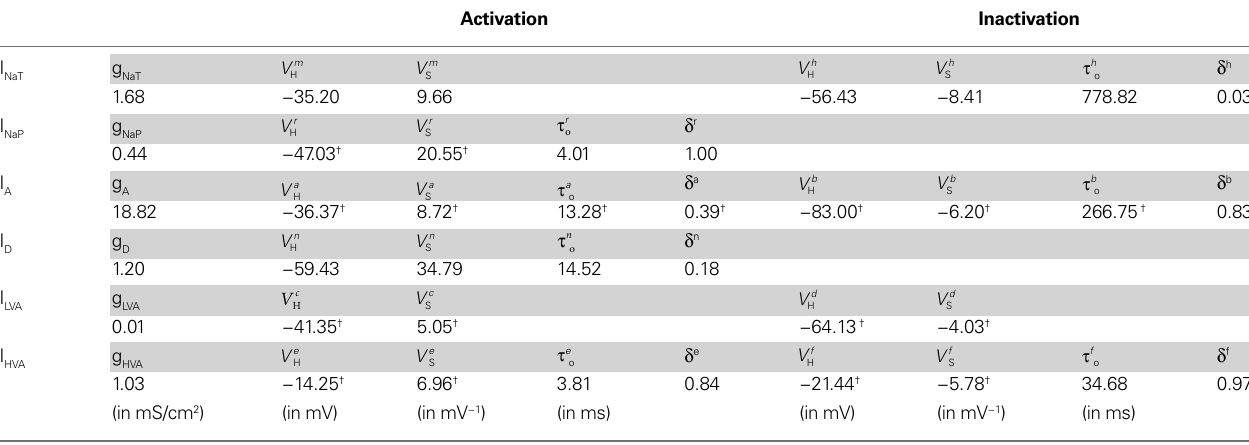
Table 1 | Estimated parameter values for all ionic currents in the fi tted CGCs model.